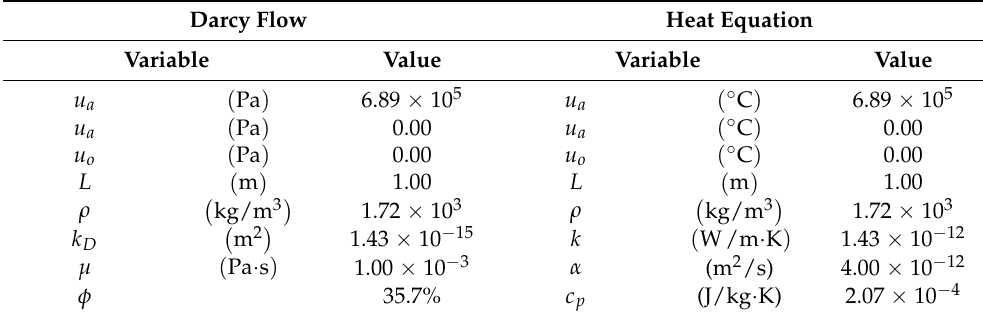
Figure 4. ( Top ): Schematic of the 1D flow model used in the analytical and FEA model comparison. Figure 4. Top : Schematic of the 1D fl ow model used in the analytical and FEA model comparison. ( Bottom ): Snapshot of a portion of the gridded FEA model and the corresponding scale. Bo tt om : Snapshot of a portion of the gridded FEA model and the corresponding scale. Table 1. Input parameters used in the analytical and FEA